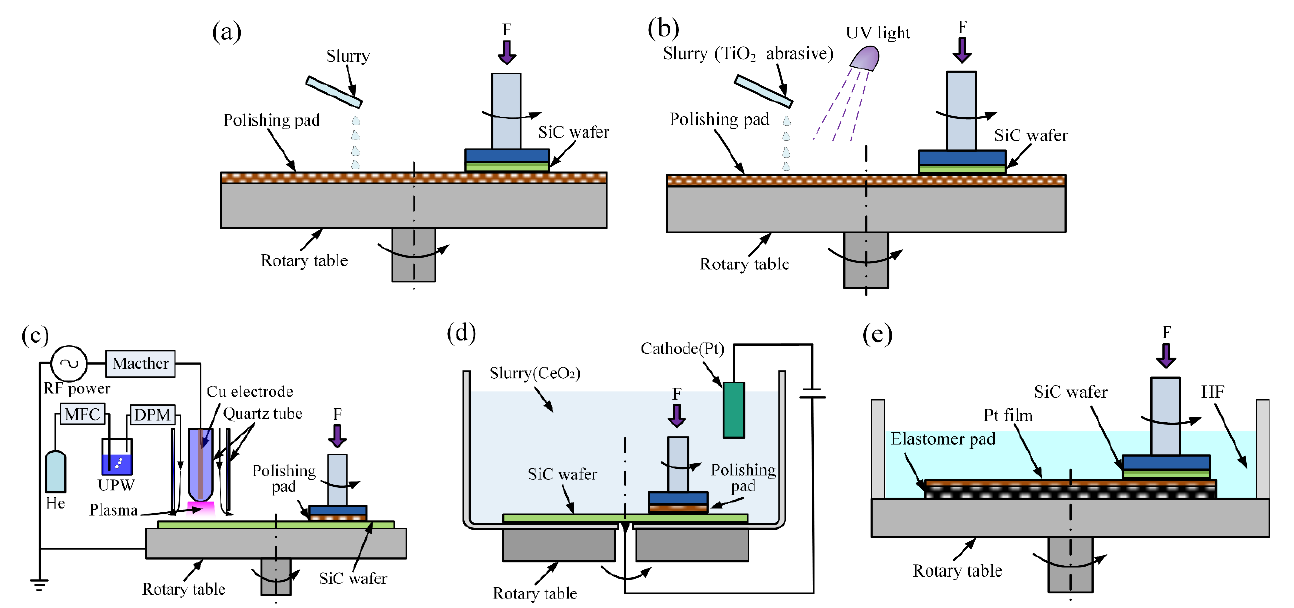
Figure 31. Schematic of the different experimental setups: ( a ) CMP [21], ( b ) PCMP [14], ( c ) PAP [38], ( d ) ECMP [15], and ( e ) CARE [58].